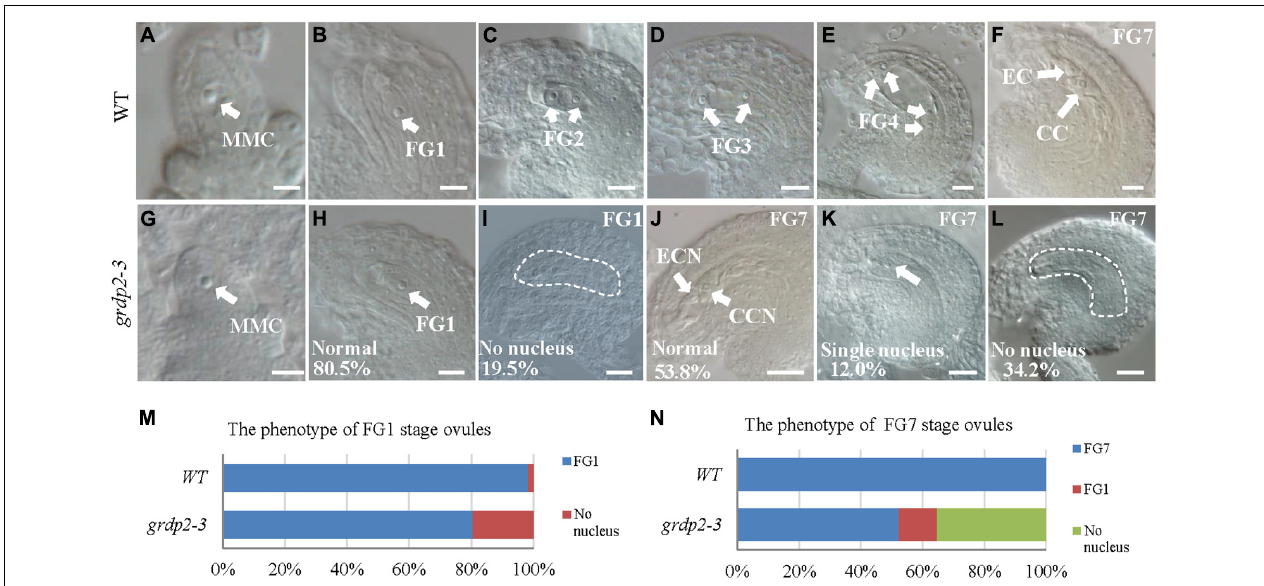
FIGURE 3 | Female gametogenesis in WT and grdp2-3 plants examined by differential interference contrast microscope (DIC). Bar = 50 µ m. (A) Megaspore mother cell (MMC) of WT plants. (B) 98.3% of 121 examined FG1 stage from WT normal ovules. (C–F) Female gametogenesis from FG2 to FG7 was normal in WT plants. (G) Megaspore mother cell (MMC) of grdp2-3 plants. (H) 80.5% of 221 examined FG1 stage ovules from grdp2-3 plants were normal. (I) 19.5% of 221 examined FG1 stage ovules from grdp2-3 plants showed no nucleus. (J) 53.8% of 179 examined FG7 stage ovules from grdp2-3 plants were normal. (K) 12.0% 179 examined FG7 stage ovules from grdp2-3 plants showed single nucleus. (L) 34.2% of 179 examined FG7 stage ovules from grdp2-3 plants showed no nucleus. (M) The phenotype analysis of FG1 stage ovules in WT and grdp2-3 plants. (N) The phenotype analysis of FG7 stage ovules in WT and grdp2-3 plants. CCN, central cell nuclei; EC, egg cell nuclei; FG, female gametophyte; white arrows mean nuclei; white dotted lines mean embryo